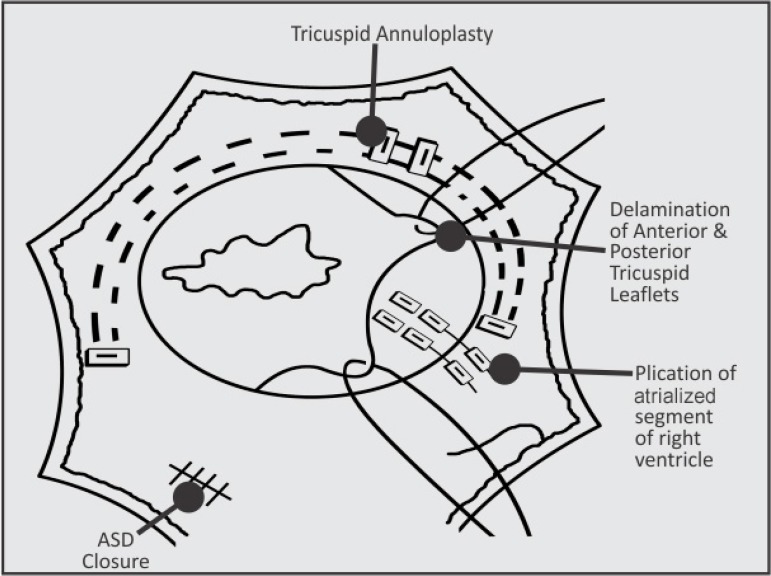
Diagrammatic presentation of repair - after delamination, atrialized
RV is plicated in vertical fashion just closer to true tricuspid
annulus. The true tricuspid annulus is circumferentially plicated
using two 5-0 polypropylene suture to create a neoannulus.ASD=atrial septal defect